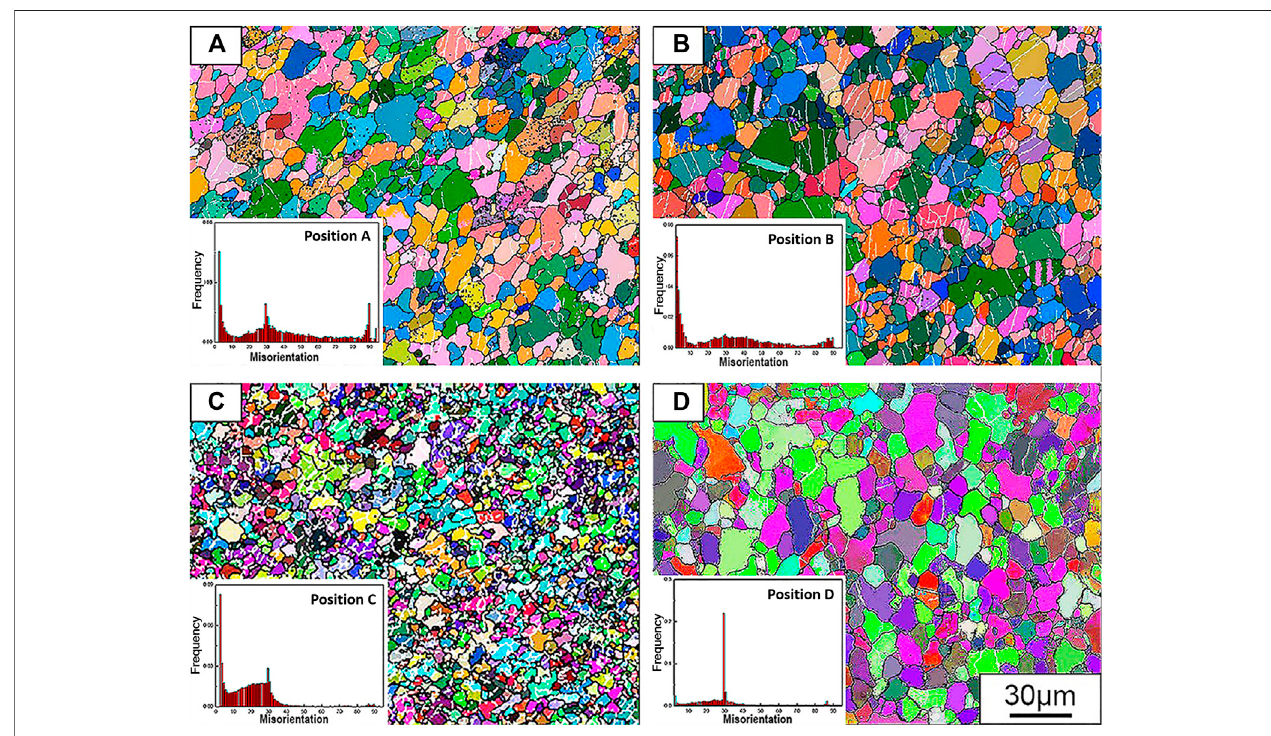
FIGURE 8 | Microstructures and grain size distributions of the samples at different positions of the “ stop action ” zone showed in Figure 2B . (A) position A; (B) position B; (C) position C; and (D) position D.